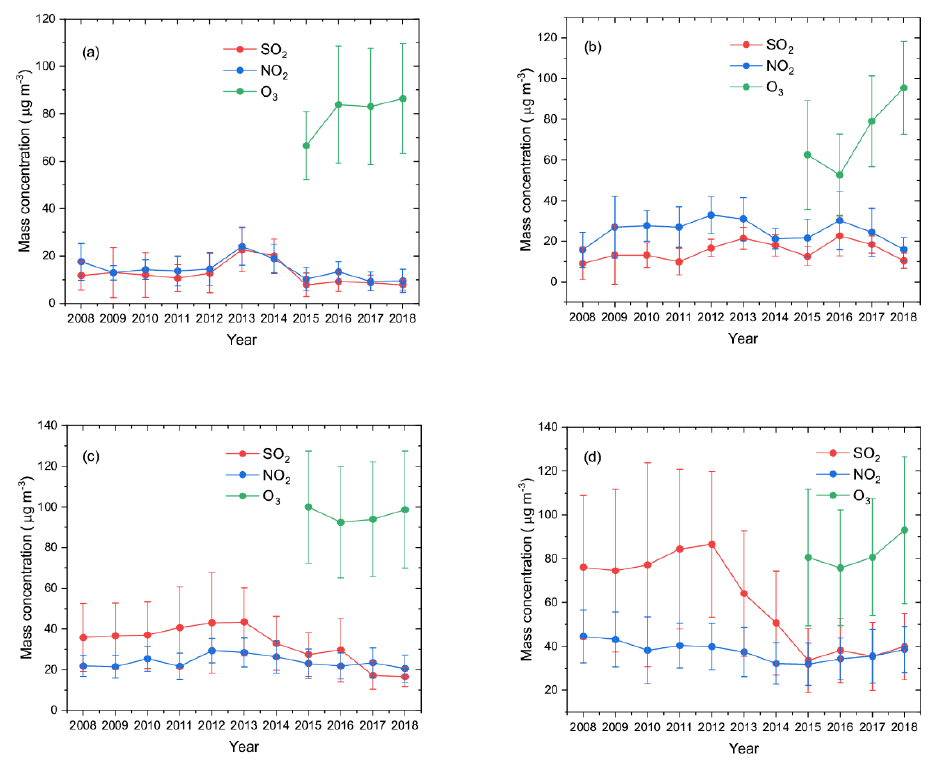
Figure 3. Variations of annual mean mass concentrations of SO 2 , NO 2 , and O 3 in ( a ) Aba, ( b ) Ganzi, ( c ) Liangshan, and ( d ) Panzhihua from 2008 to 2018.